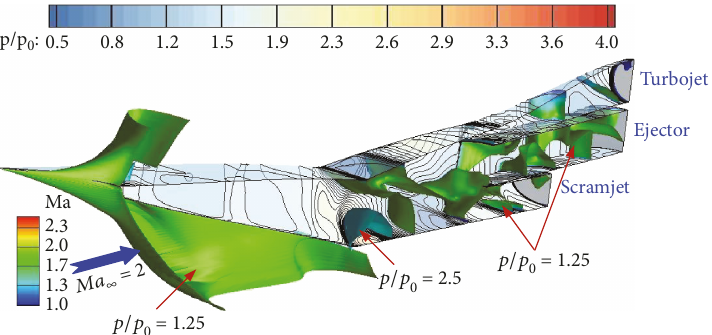
= 2 . The surface wall is contoured by the pressure ratio p/p ∞